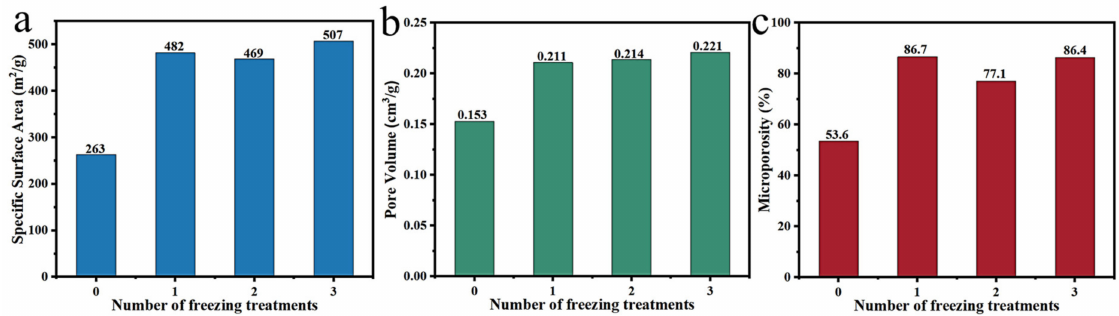
Figure 9. ( a – c ) Impact of number of freezing treatments on freeze treatment effect [98].